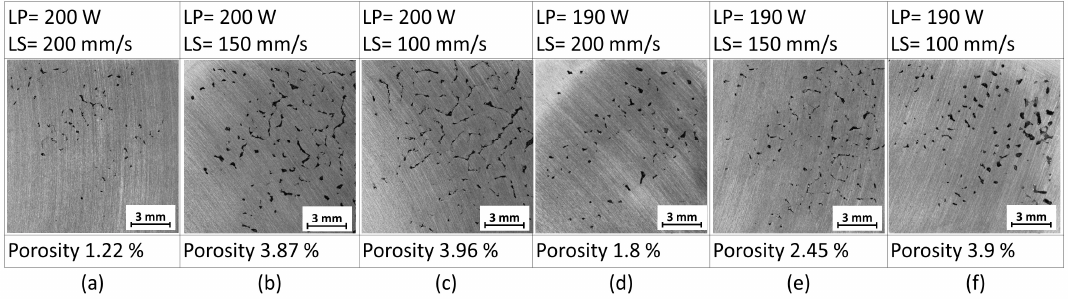
Figure 7. Influence of LP and LS variance on the defect formation using the chessboard strategy.